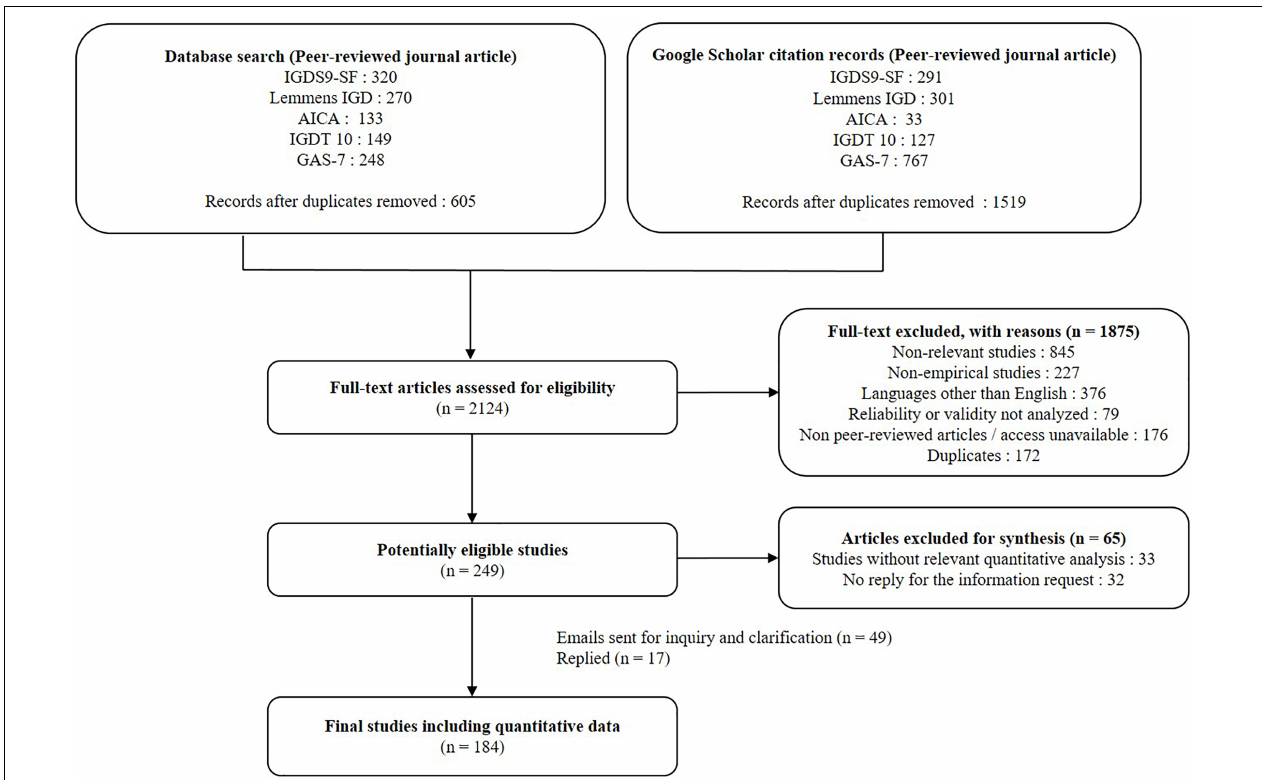
FIGURE 1 | Flow chart of the search process in accordance with PRISMA